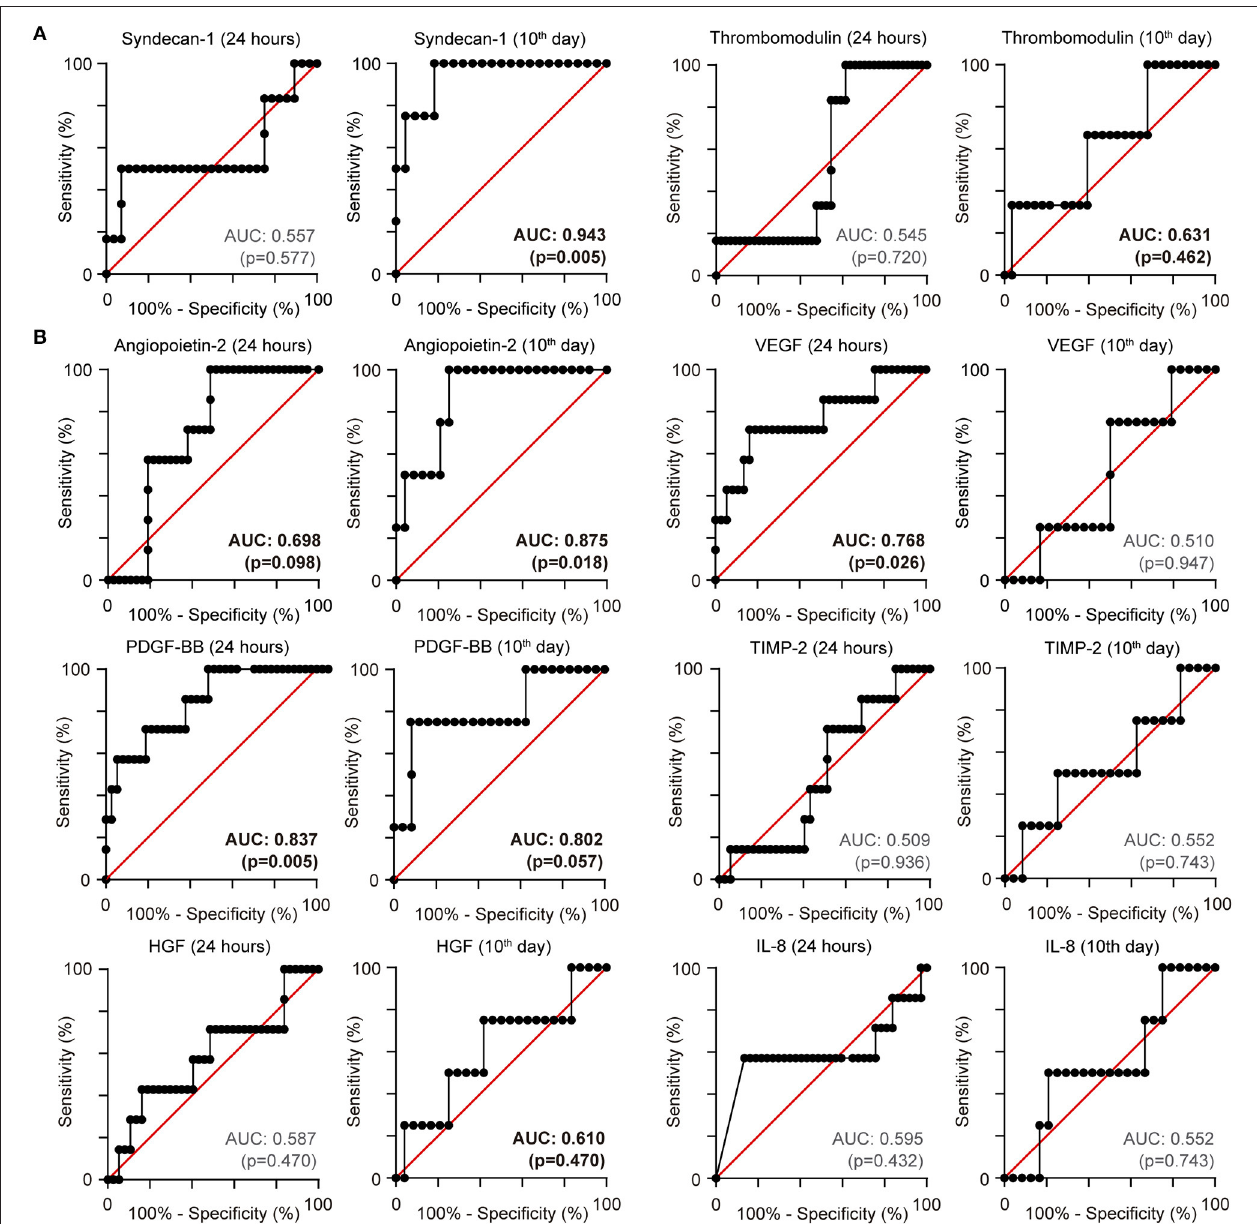
FIGURE 2 | Receiver operating characteristic (ROC) curve for mortality: (A) Endothelial biomarkers (B) Angiogenic biomarkers. ROC curves with area under the curve for